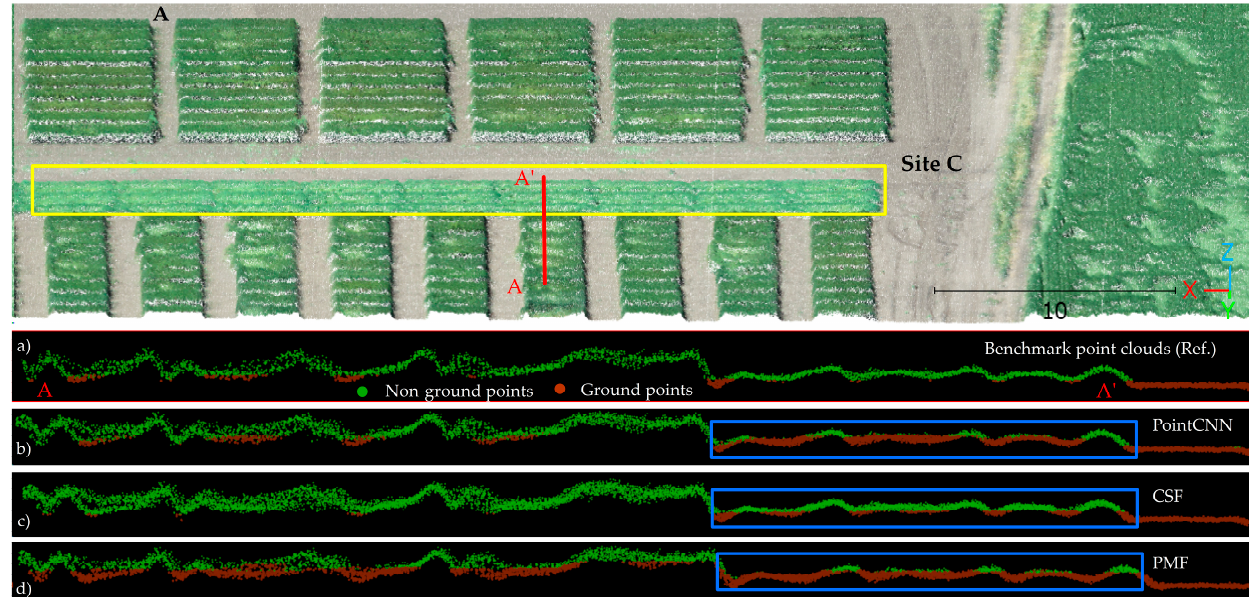
Figure 13. ( A ) Colored DJI L1 point clouds (Site C), 3D transects (AA’) of ground and non ‐ ground points: ( a ) Transect representative of pulse-crop with benchmark point clouds. Ground and non- points: ( a ) Transect representative of pulse ‐ crop with benchmark point clouds. Ground and non ‐ ground points are filtered by ( b ) PointCNN, ( c ) CSF, and ( d ) PMF. AA’ transects ( a – d ) are of the ground points are filtered by ( b ) PointCNN, ( c ) CSF, and ( d ) PMF. AA (cid:48) transects ( a – d ) are of the same same extent (horizontal) for visualization purposes with no vertical scale. extent (horizontal) for visualization purposes with no vertical